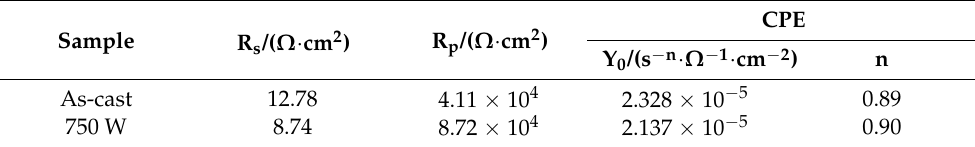
Figure 8. Nyquist plot and fitted circuit diagram before and after laser remelting trea tment for the AlCoCrFeNi 2.1 high-entropy alloy. Table 3. Electrochemical impedance spectrum fitted results.